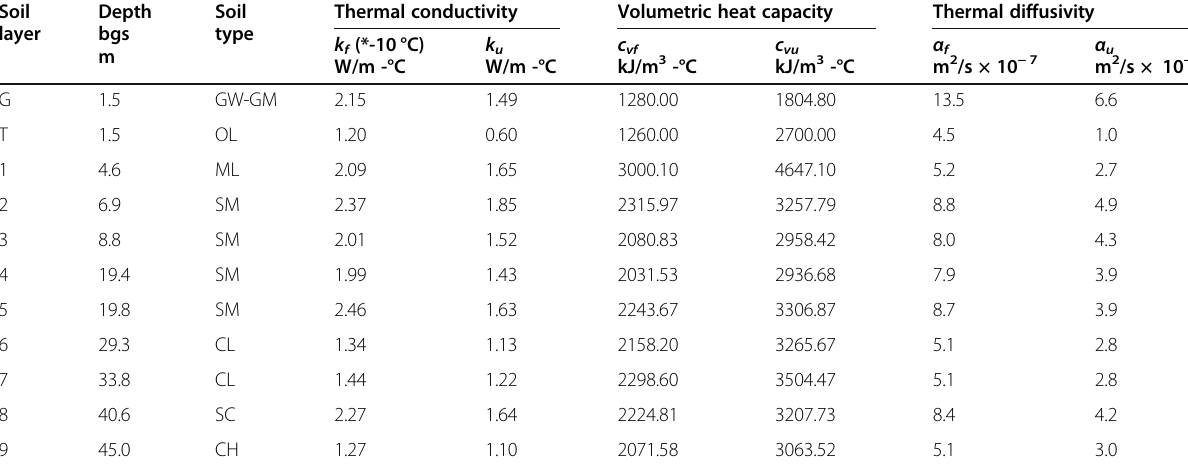
Table 2 Thermal properties of each layer used in this study Soil Depth layer bgs